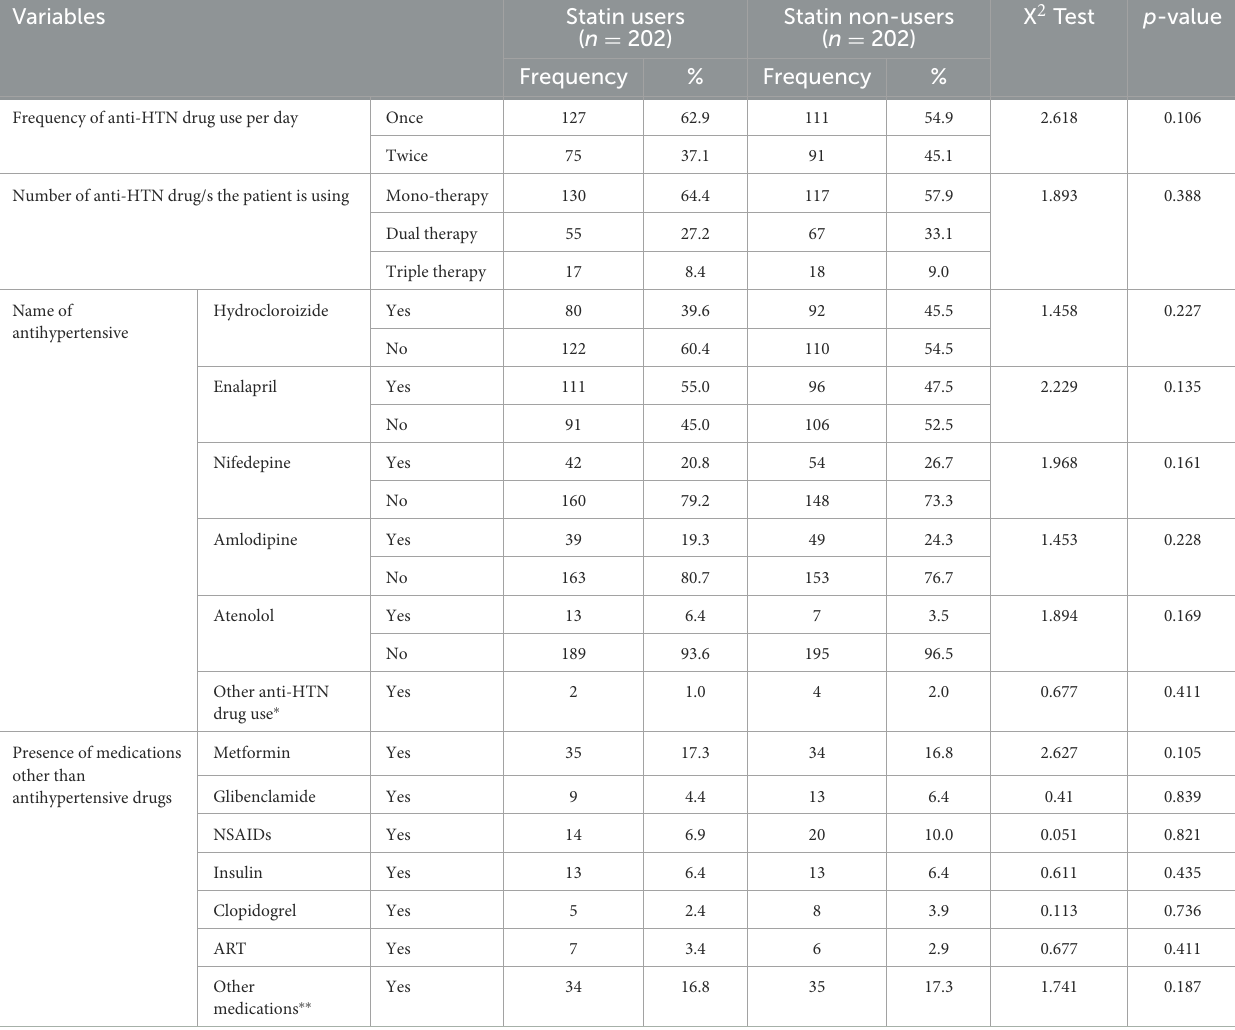
TABLE 4 Medications-related characteristics of patients with hypertension attending the outpatient clinic at FHCSH, northwest Ethiopia. Variables Statin users ( n =